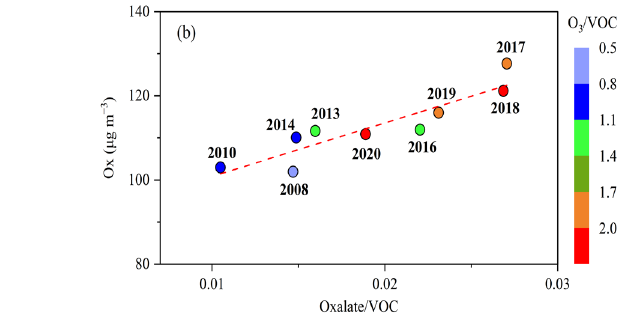
Figure 9. ( a ) Interannual variation of the oxalate/PM 2.5 , oxalate/sulfate and oxalate-C/OC ratios in Shanghai; ( b ) Oxalate/VOC correlation with Ox (2008–2020).